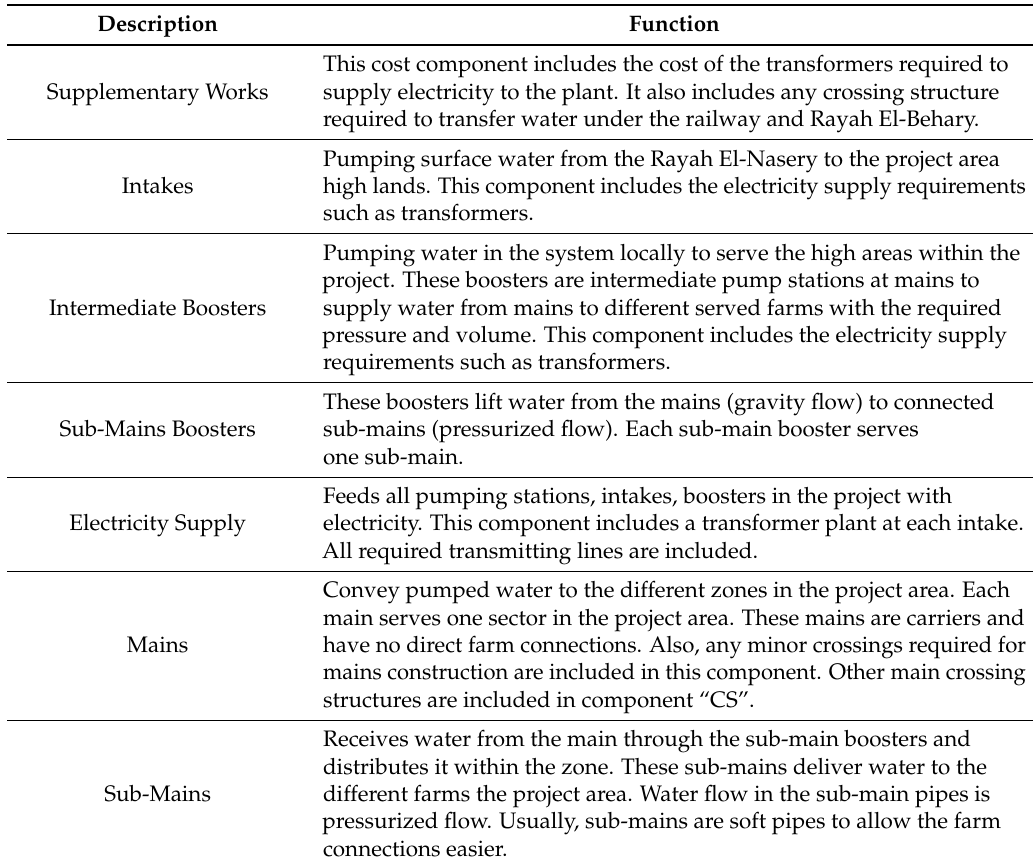
Table A1. Investment Cost Categories under Scenario